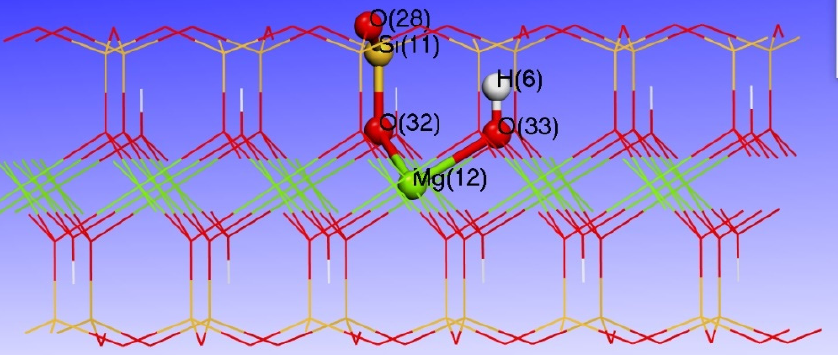
Figure 2. Emmetropia of the (2 × 2 × 1) supercrystal cell on talc (001) surface under ideal condition.